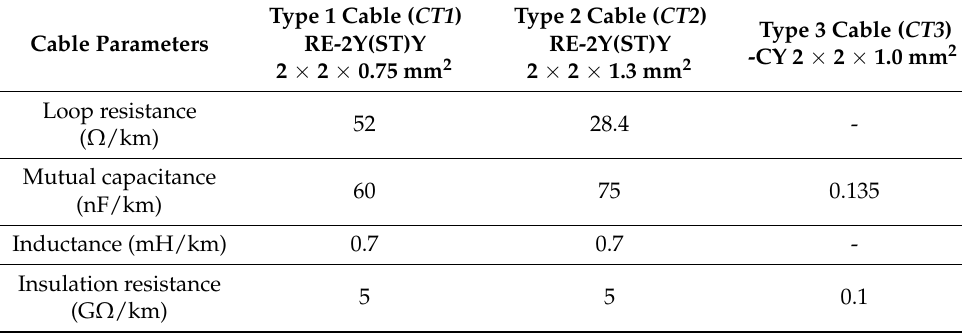
Table 1. Distributed parameters of CT1, CT2, and CT3. Figure 3. Photo of CT1, CT2, and CT3.